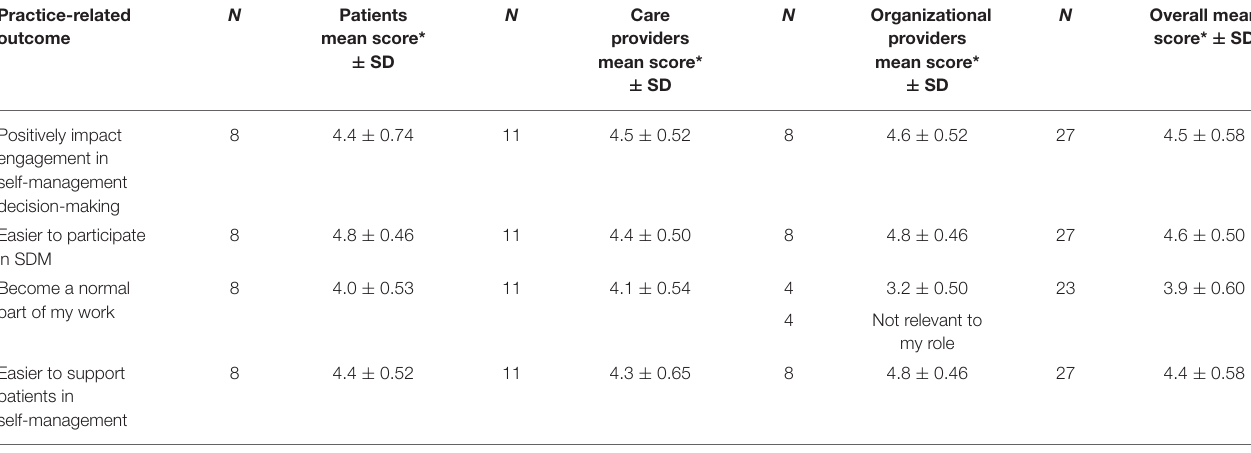
TABLE 9 | Mean practice-related outcomes scores by study group.